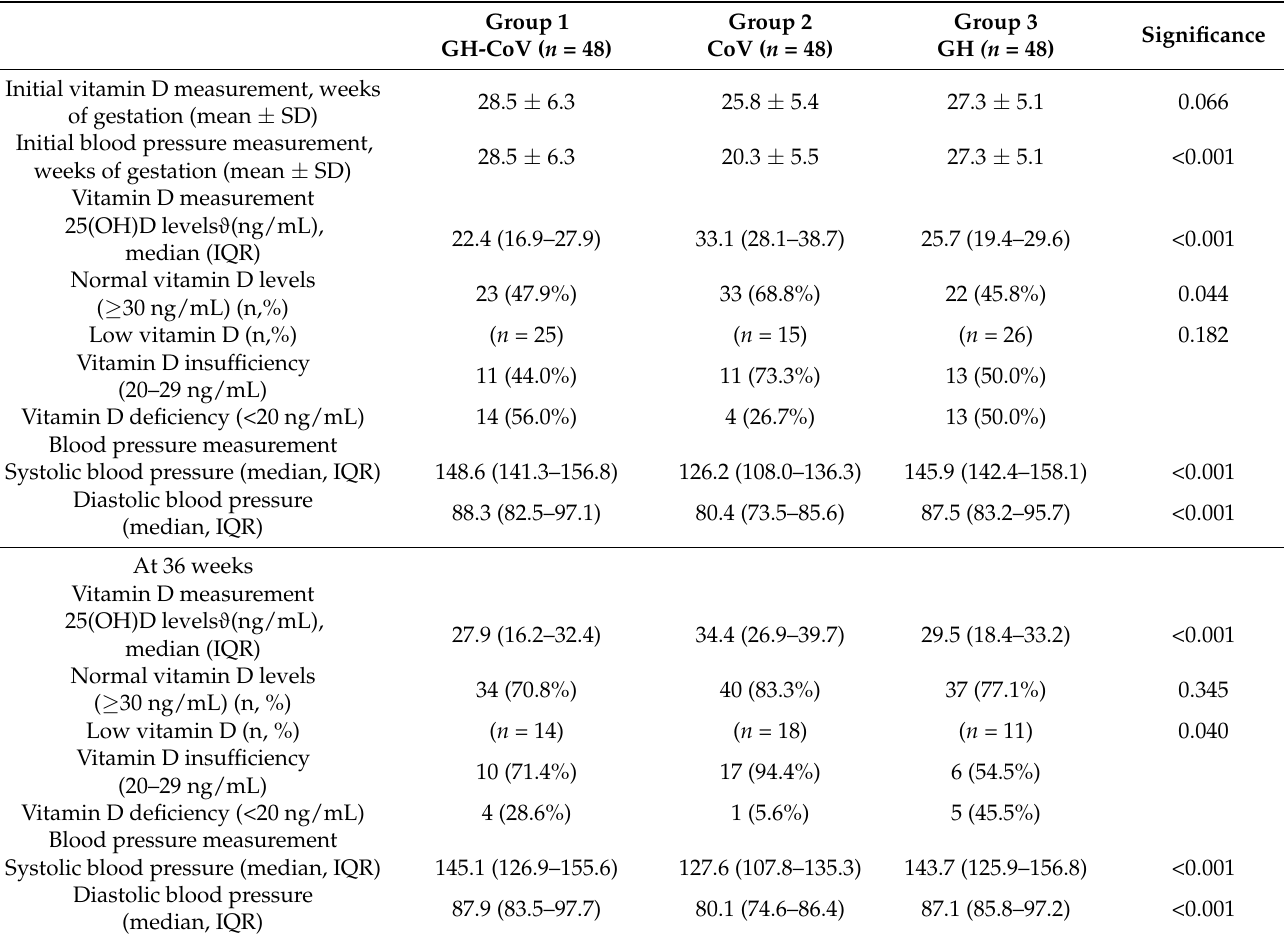
Table 3. Comparison of vitamin D measurements and blood pressure between study groups.